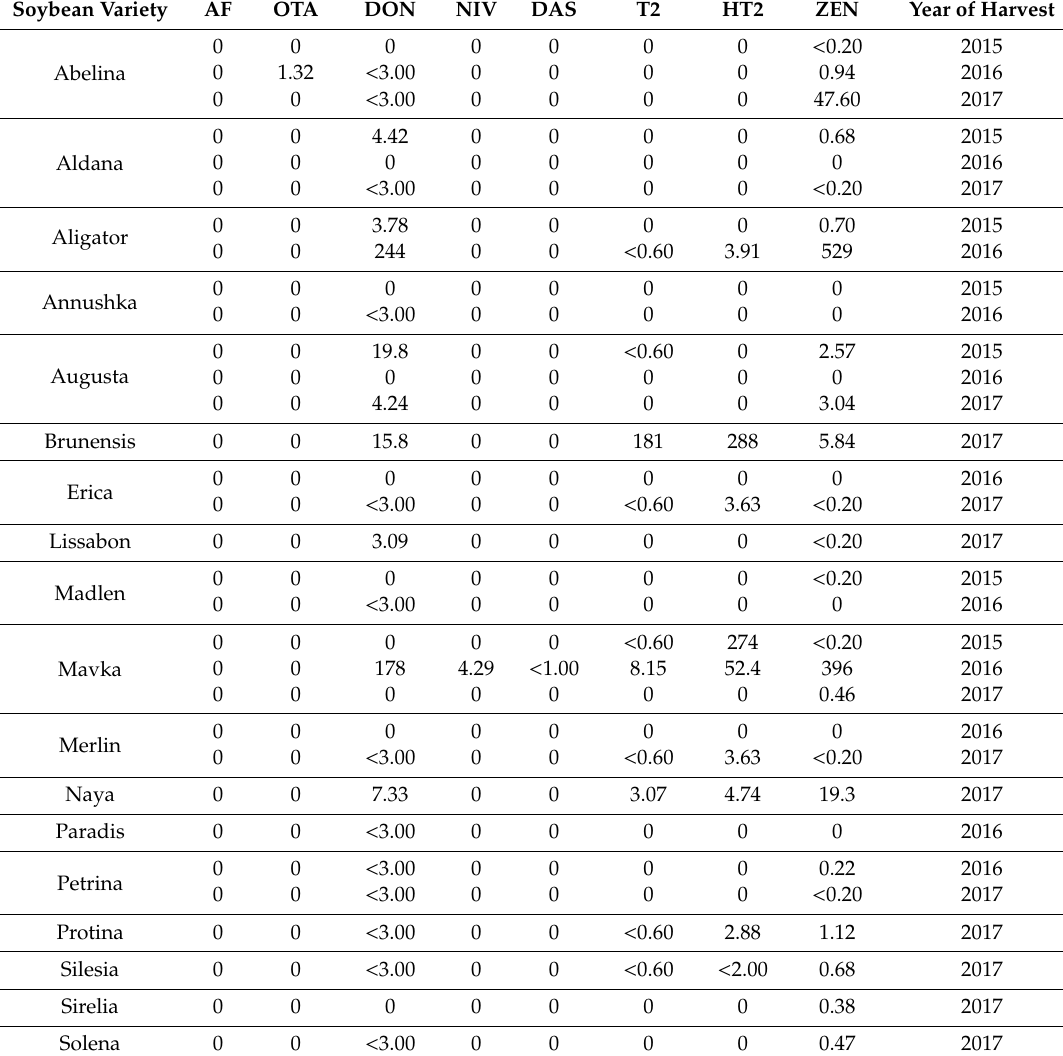
Table 5. Presence of mycotoxins in di ff erent varieties and harvest years of soybean seeds (ppb). Soybean